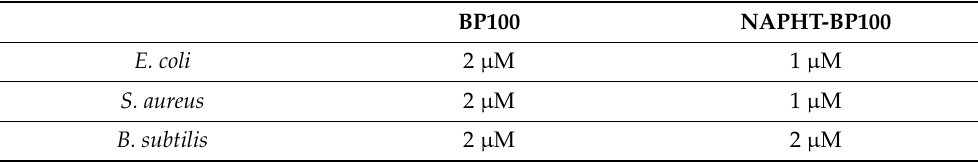
Table 4. Minimum inhibition concentration (MIC) values for BP100 and